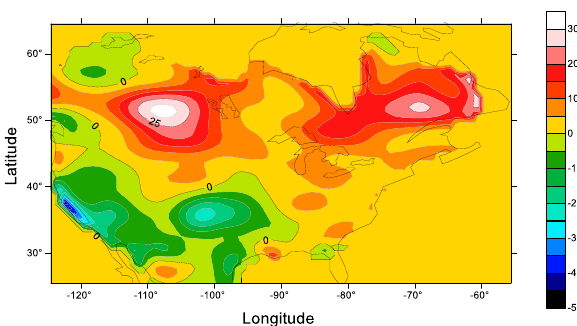
Figure 2. Trend rates of the lake water level changes in North America (x10 -3 m /yr.)